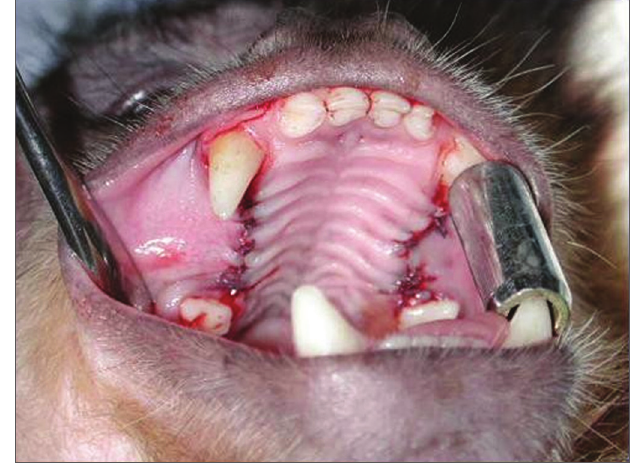
Figure 5. Repositioned and sutured mucoperiosteal